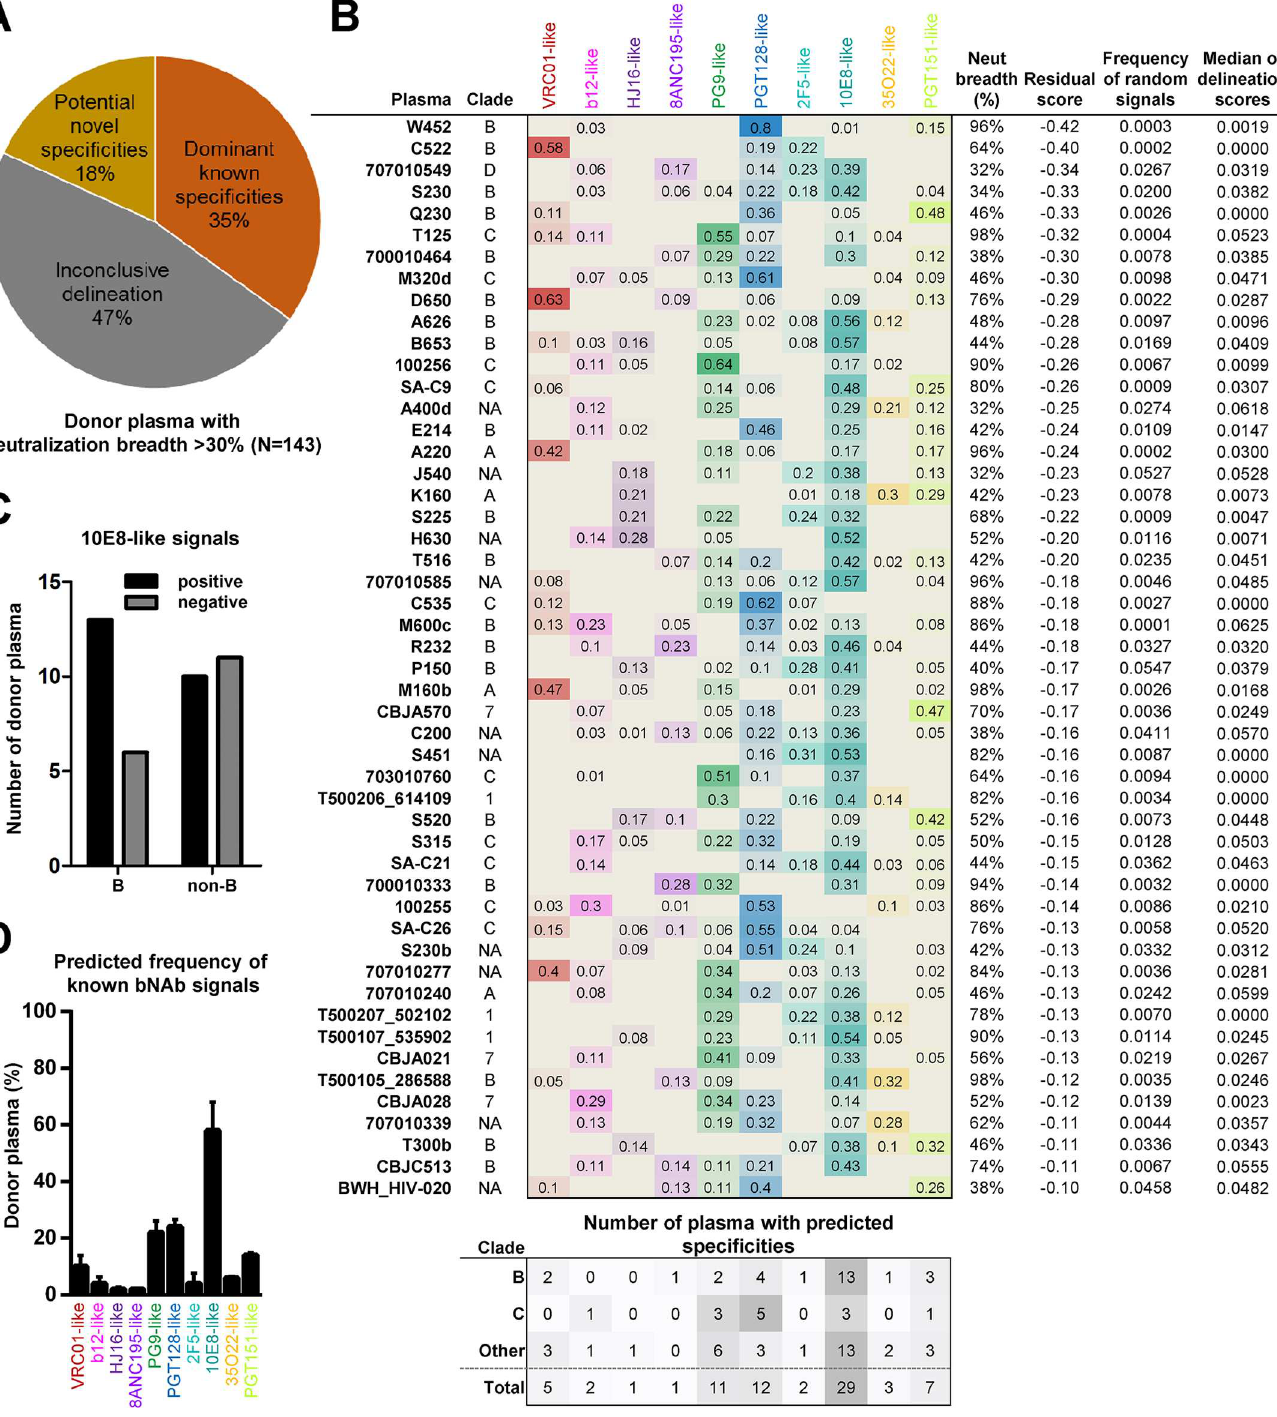
Fig 7. Large-scale analysis of HIV-infected donors. (A) NFP predictions for 143 donor plasma were dividedinto three groups: plasma with dominant known specificities, with potentially novel specificities, or with inconclusivedelineation.(B) Delineated antibody specificities for the 50 plasma with predicteddominant known specificities. Also shown are the clade of infection (A, B, C, D; 1: CRF 01; 7: CRF 07; NA: unknown),neutralization breadth, as well as the three confidencescores, for each sample. The numberof positive signals for clades B and C are shown at the bottom, with the ‘Other’ category includingboth non-B and non-C as well as samples with unknownclades. (C) Prevalence of 10E8-likesignalsin clade B vs. non-B samples. (D) Overall prevalenceof antibody specificities (thick bars) in the 50 samples from (B), and adjustedpredictionsafter the applicationof the cohort-level NFP algorithm(thin bars). The analysiswas based on the selected 50-strain panel from Fig 6.